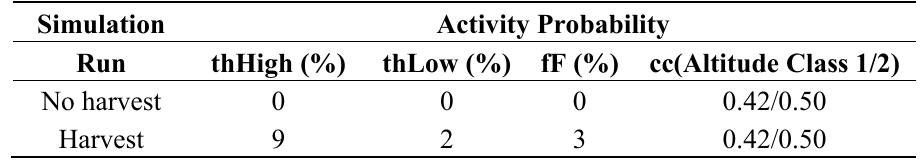
Table 1. The settings for the activity probabilities in two simulations named “No harvest” and “Harvest” with different harvesting intensities for thinning alternatives